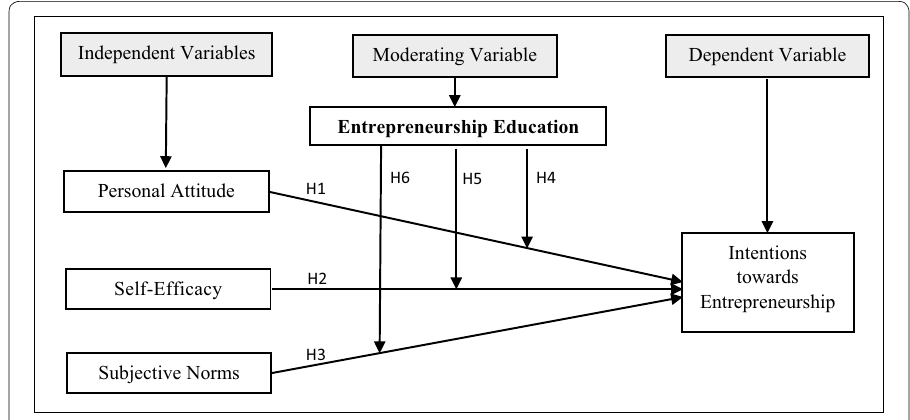
Fig. 1 Conceptual framework for evaluation of entrepreneurship